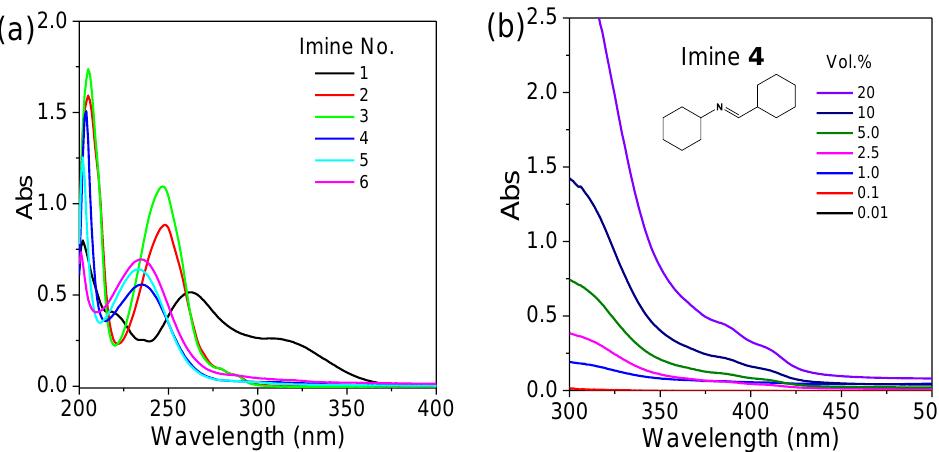
Figure 1. ( a ) UV-vis spectra of imines 1 – 6 ethanol solutions ( 2 – 6 : 0.01 vol.%, 1 : 0.0001 mol L − 1 ). ( b ) UV-vis spectra of imine 4 ethanol solutions with different concentrations.